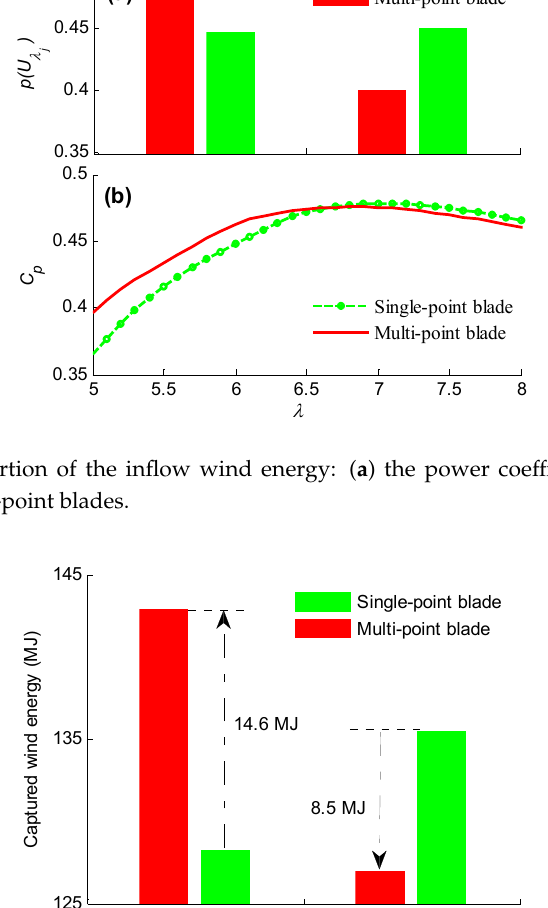
U U and . （ ） （ ） 5,6.5 6.5,8